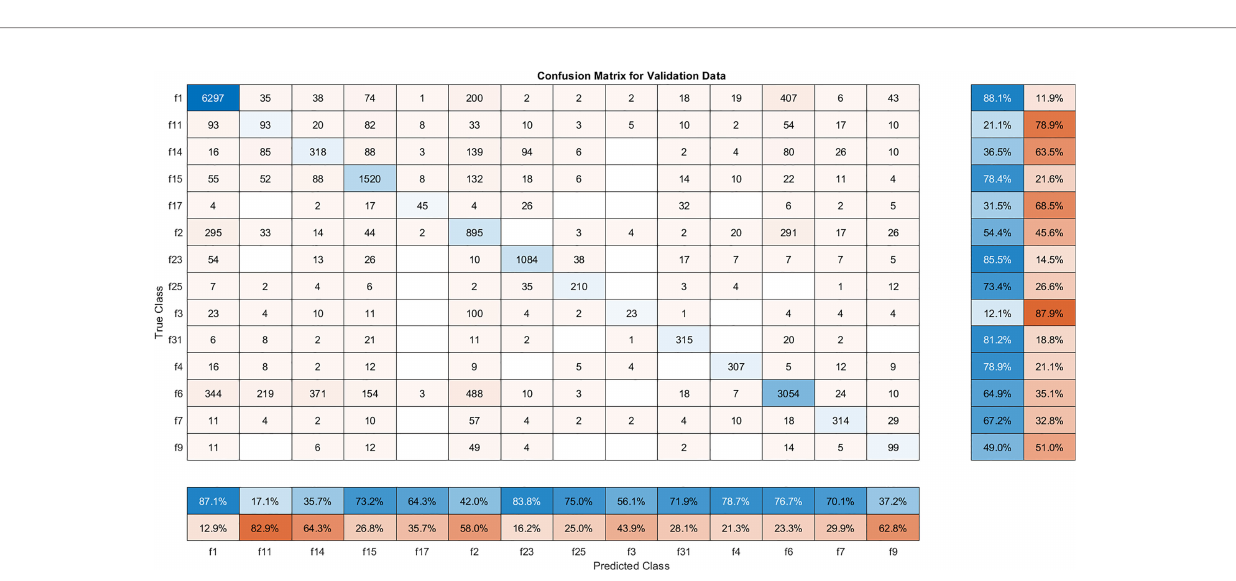
FIGURE 3 | Confusion matrix resulting from the fi rst classi fi cation experiment (50%-50% training/test partition). The two columns on the right of the confusion matrix represent the recall (blue) and the False Negative Rate (orange), respectively; the two rows below the confusion matrix represent the precision (blue) and the False Discovery Rate (orange), respectively.